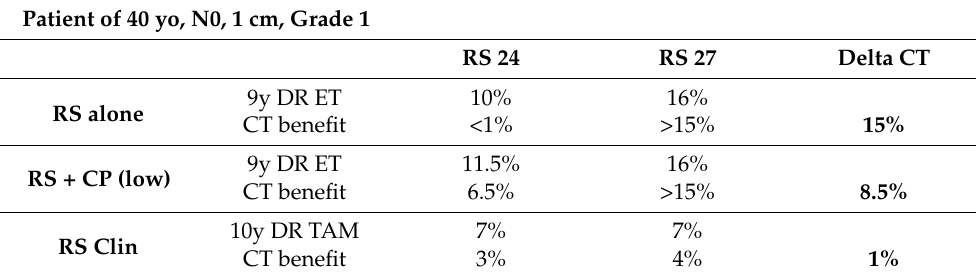
Table 1. Example of how the integration of RS Clin can refine the indication for adjuvant treatment, especially for intermediate to high RS